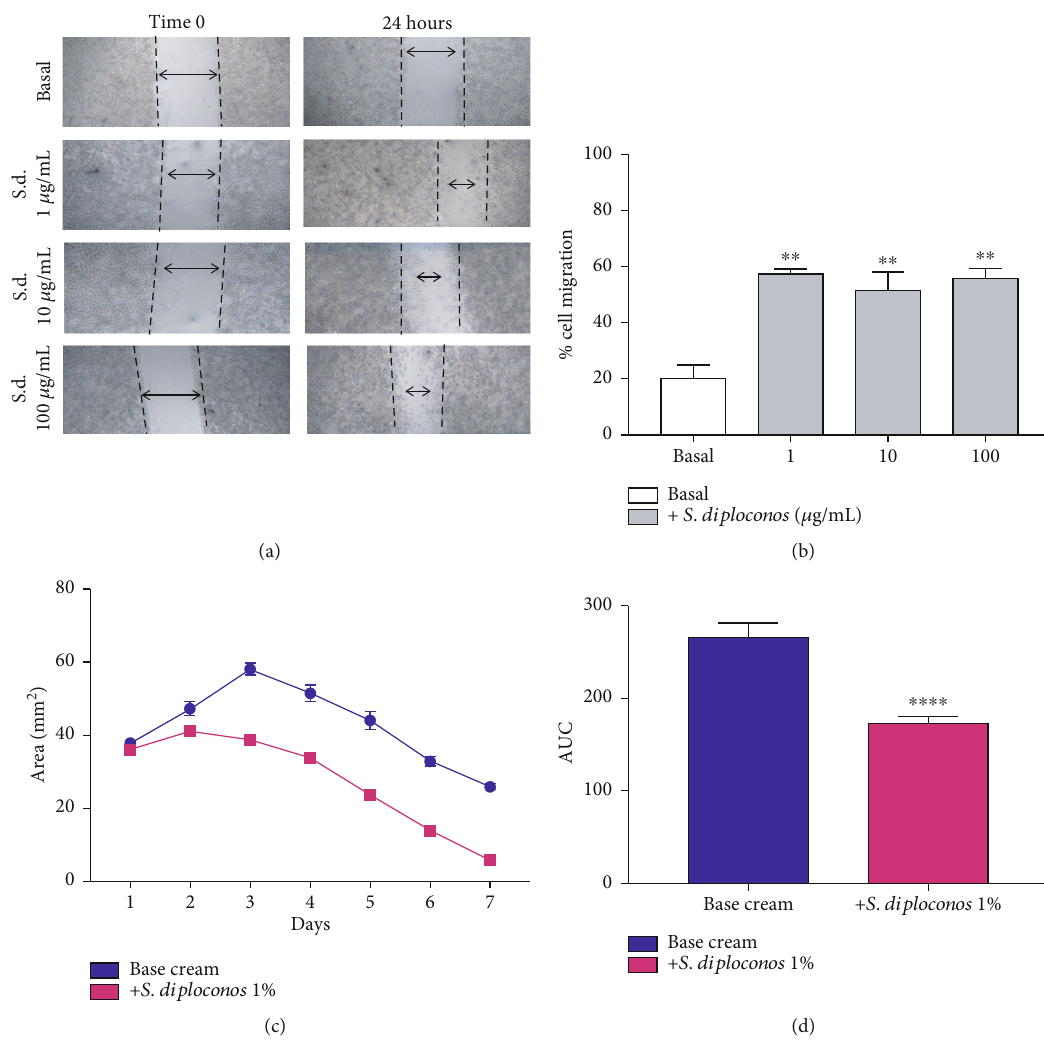
Figure 5: Analysis of the e ff ects of the S. diploconos fruit extract in fi broblast migration and wound healing. (a) Representative image of the in vitro scratch migration assay in fi broblasts (L929) and (b) percentage of fi broblast migration. Skin ulcers were treated individually with S. diploconos 1% cream or vehicle (base cream). Progression of wound healing area over time after extract treatment (c) and area under the curve (AUC) (d). Values express the mean ± SEM from 6 animals per group. Statistical analysis was performed using one-way ANOVA followed by Tukey ’ s test (cell migration assay) with ∗∗ p < 0 : 01 vs. basal and t -test (AUC assessment) ∗∗∗∗ p < 0 : 0001 vs. base cream.